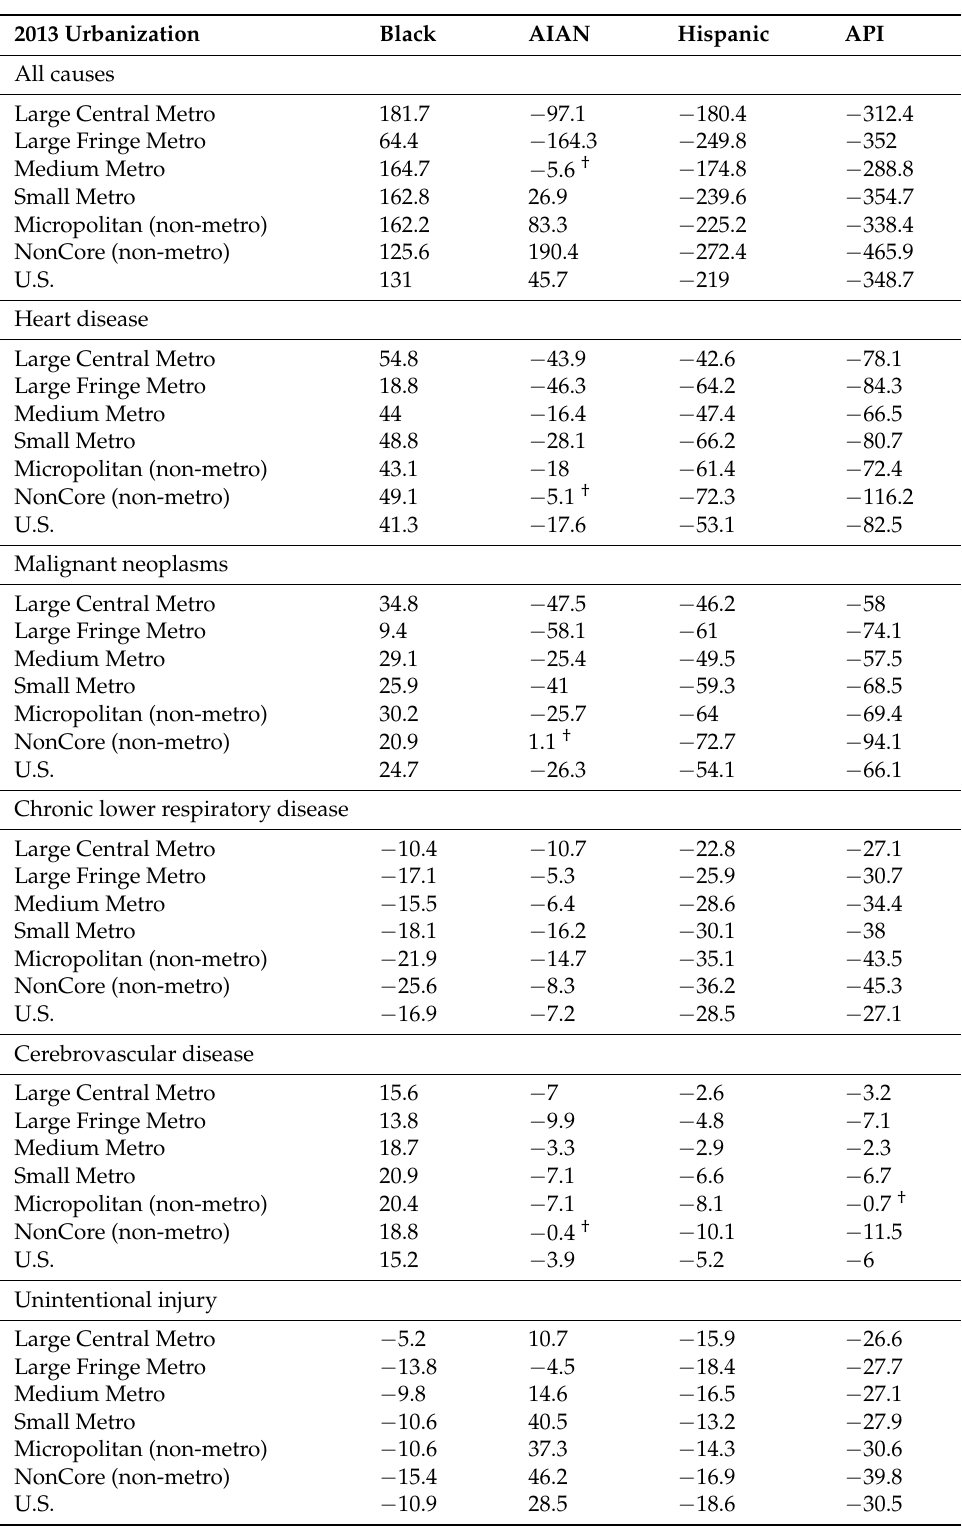
Table 8. Disparities in age adjusted mortality rates for race/ethnicity * groups compared to non-Hispanic white population by urbanization—National Vital Statistics System, United States,